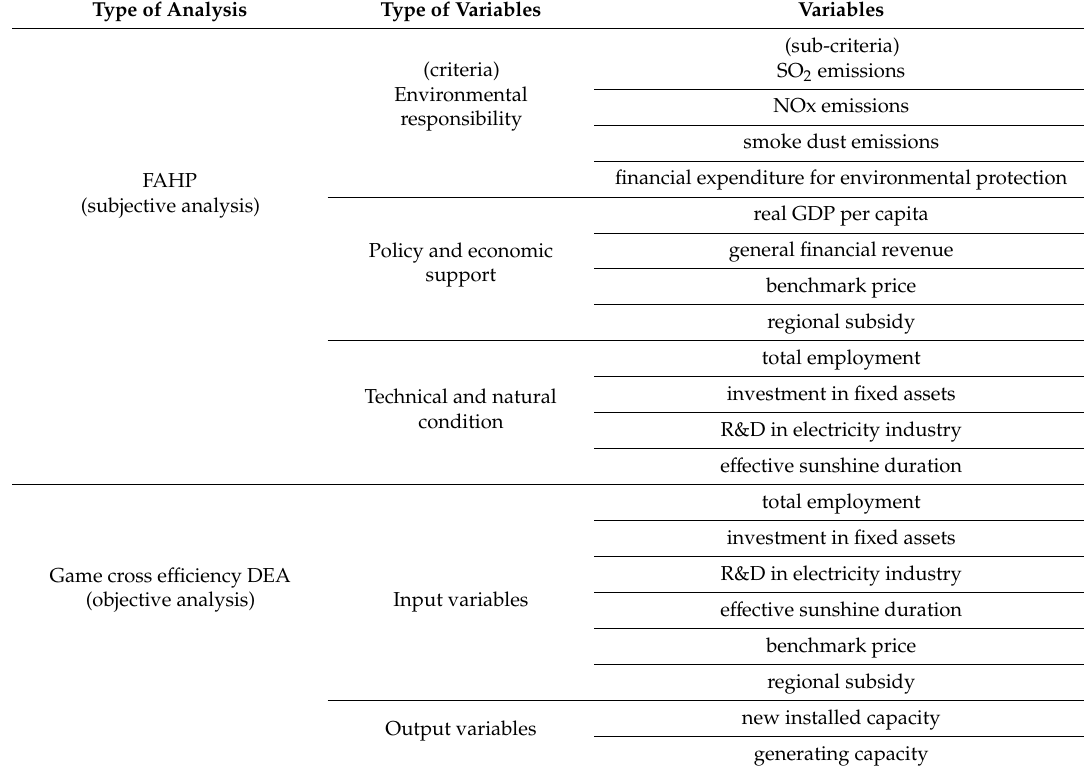
Table 1. Description of variables included in this